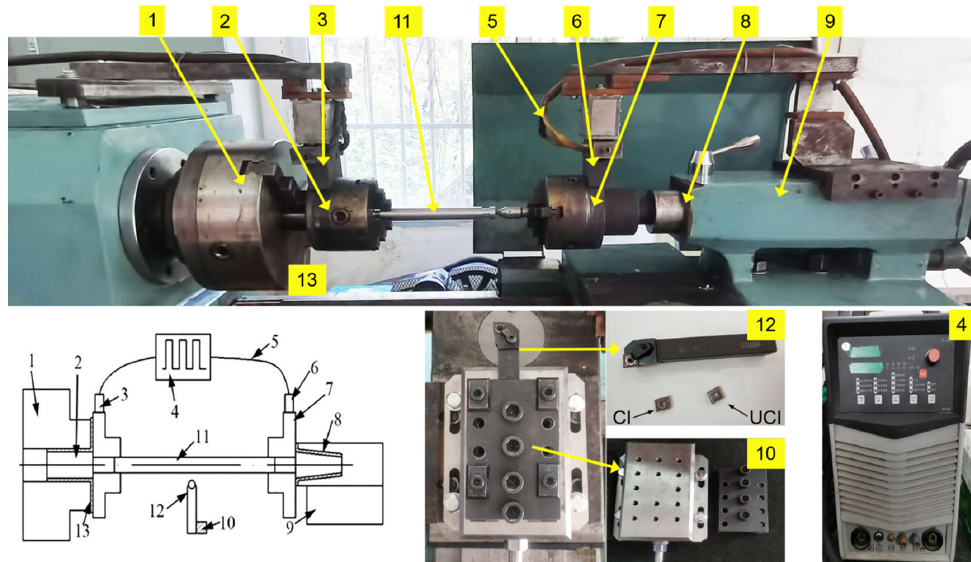
Figure 2. Schematic diagram of the experimental system: (1) chuck of the machine, (2) chuck with a cylindrical handle, (3) left carbon brush, (4) electric pulse supply, (5) wire, (6) right carbon brush, (7) chuck with a conical handle, (8) insulation casing, (9) tailstock, (10) insulation shim, (11) workpiece, (12) turning tool, and (13) insulation part.